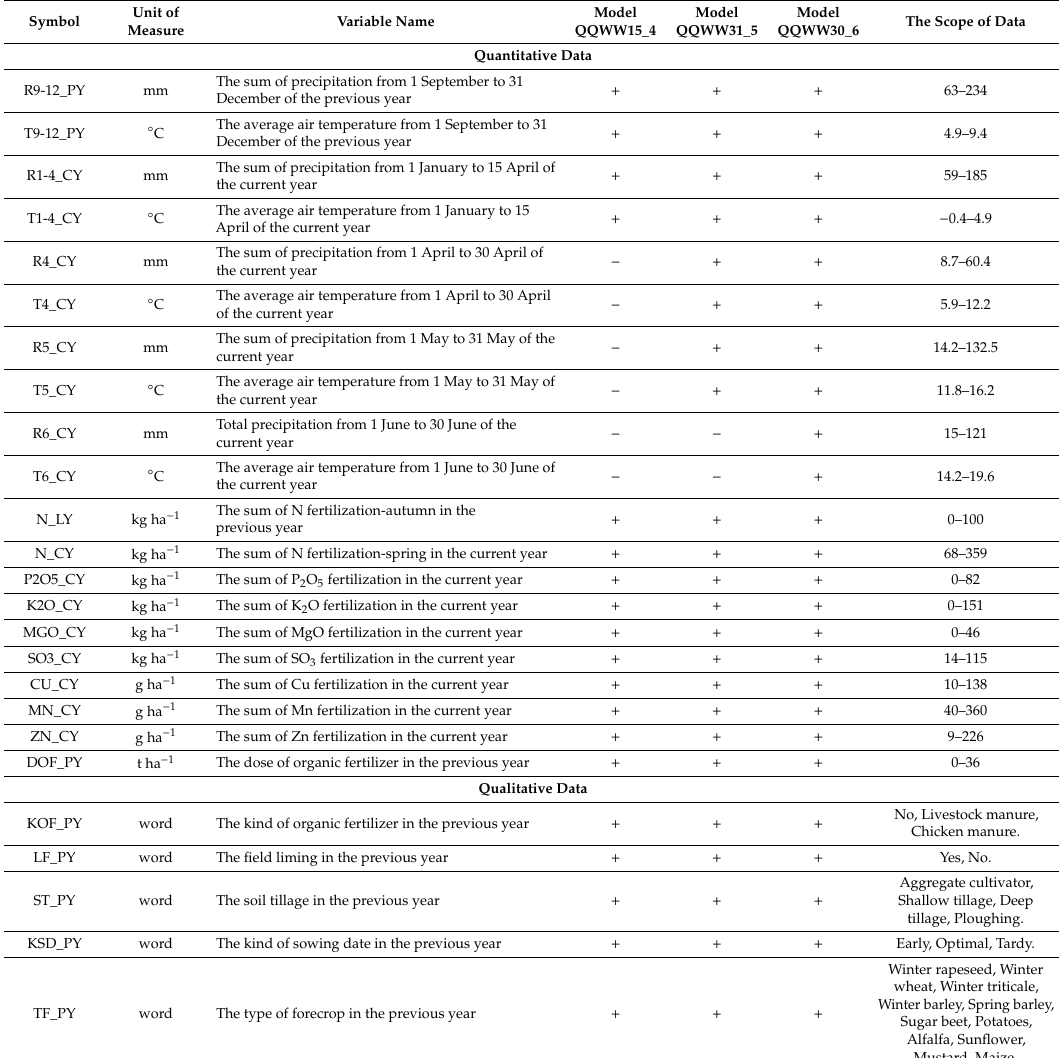
Table 2. Data structure in neural prediction